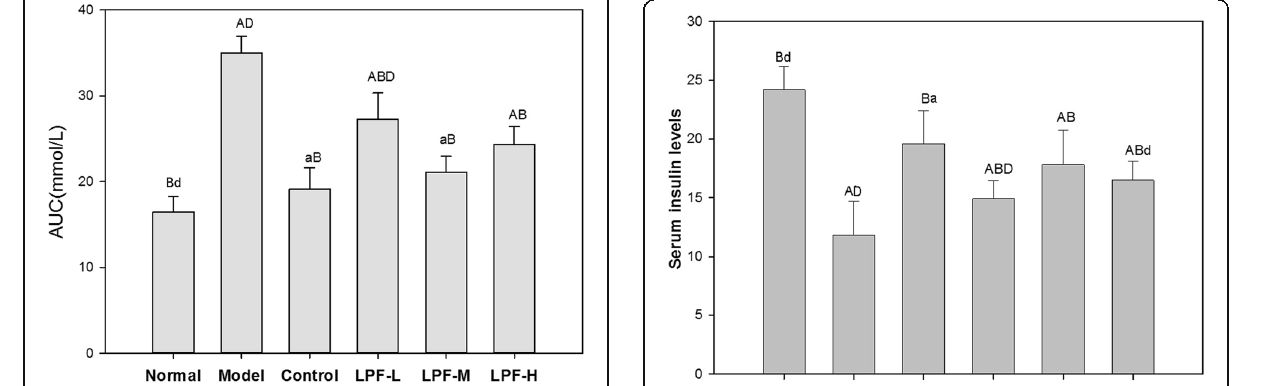
Fig. 3 Effects of flavonoids from Lotus plumule on AUC level of T2DM mice. The results were expressed as mean ± SD ( n = 8/group). A p < 0.01, a p < 0.05, compared with normal group; B p < 0.01, b p < 0.05, compared with model group; D p < 0.01, d p < 0.05, compared